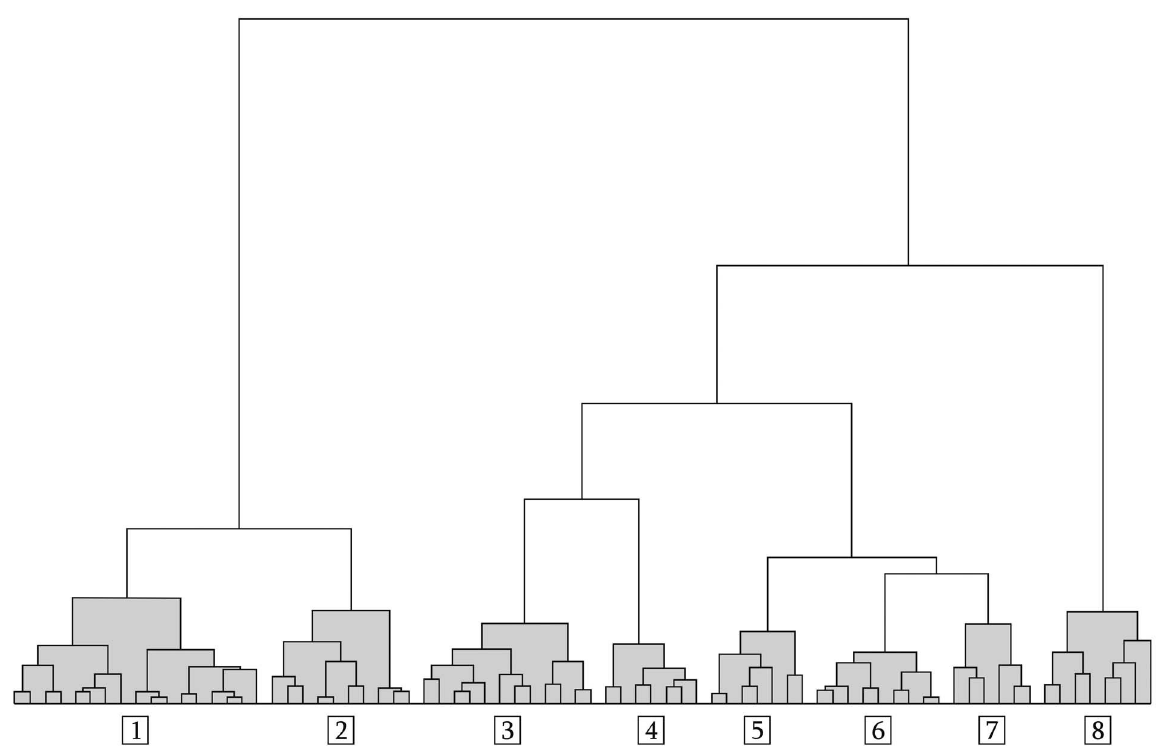
Fig. 2. Dendrogram for 76 geomorphosites under study (comp. Fig. 1B and Table 3)